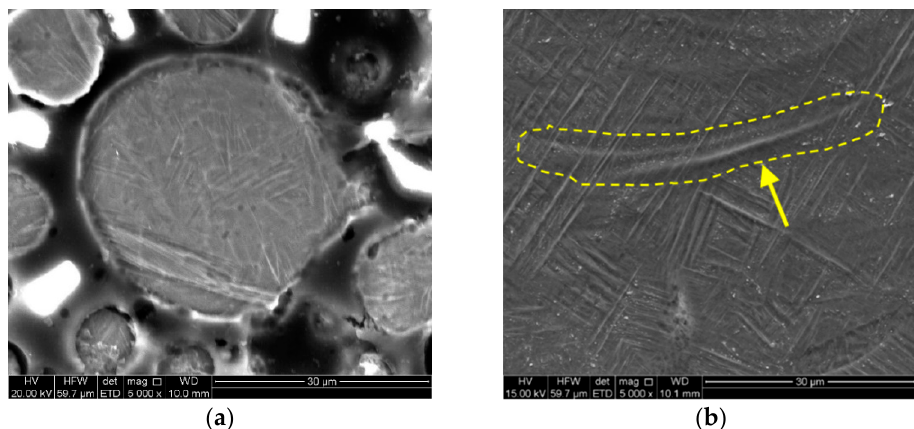
Figure 4. SEM micrographs of etched ( a ) starting powder particles and ( b ) L-PBF sample.